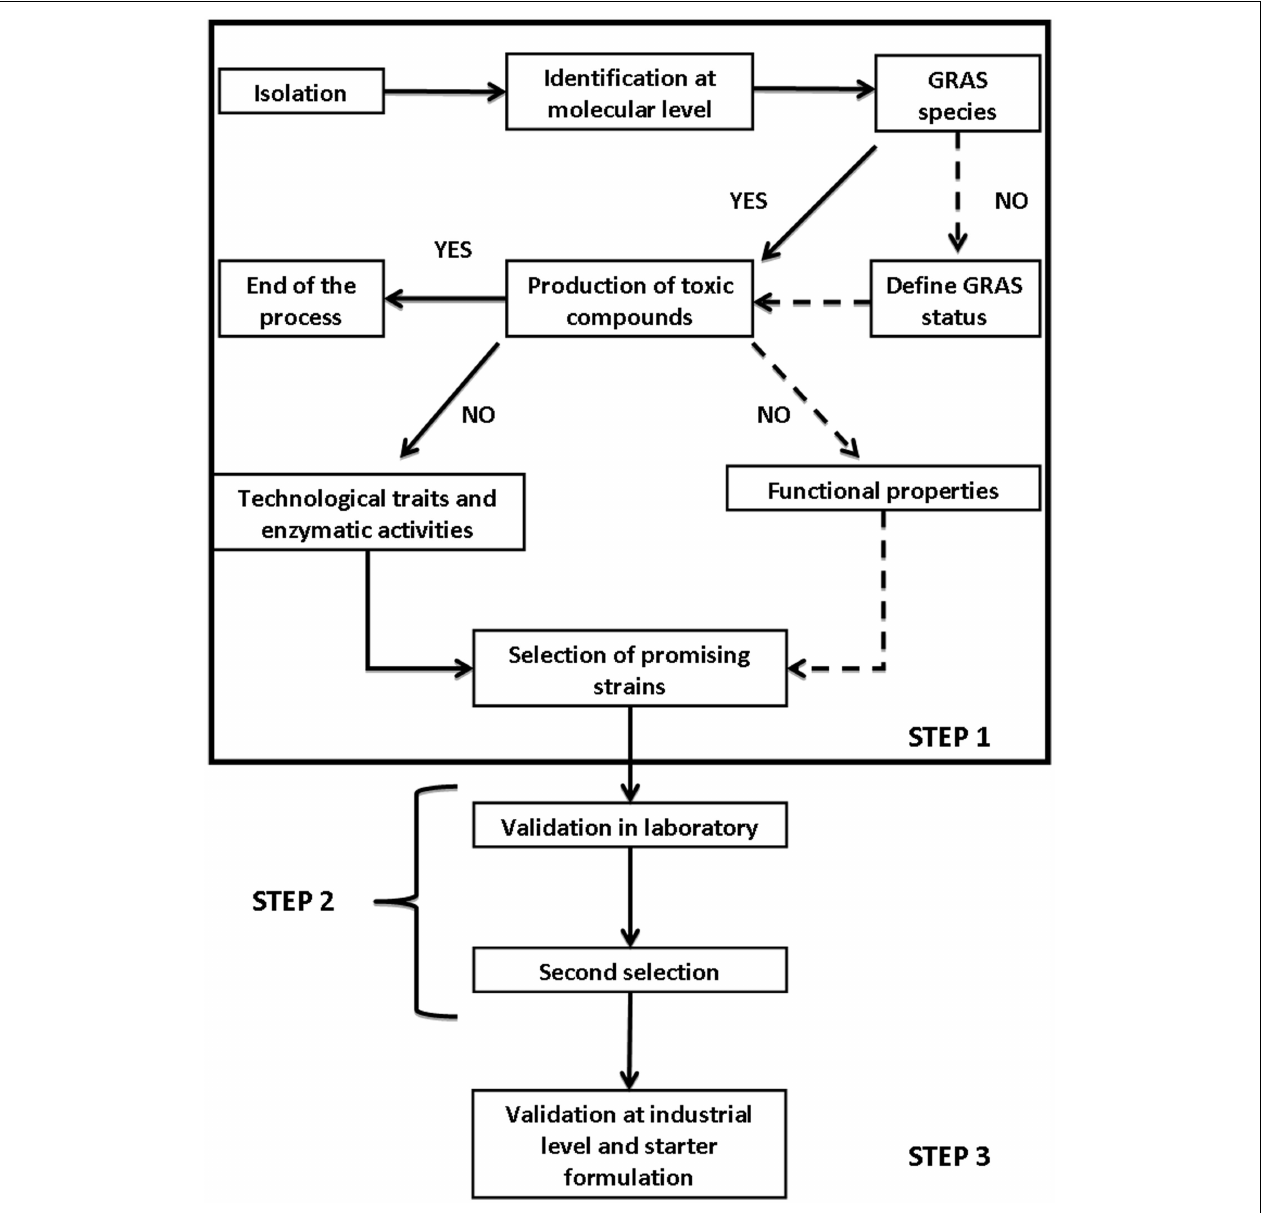
FIGURE 1 | Flow-sheet for the selection of a starter